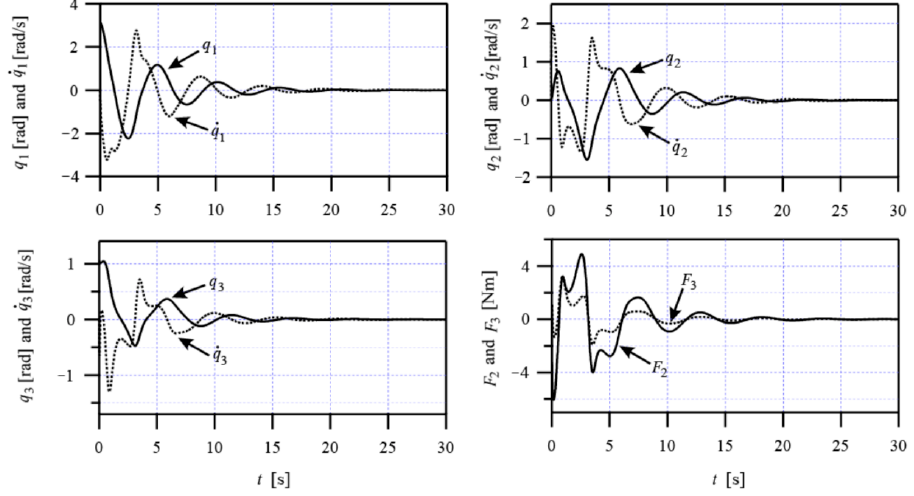
Figure 2. Simulation results for the control system (1) and (2).